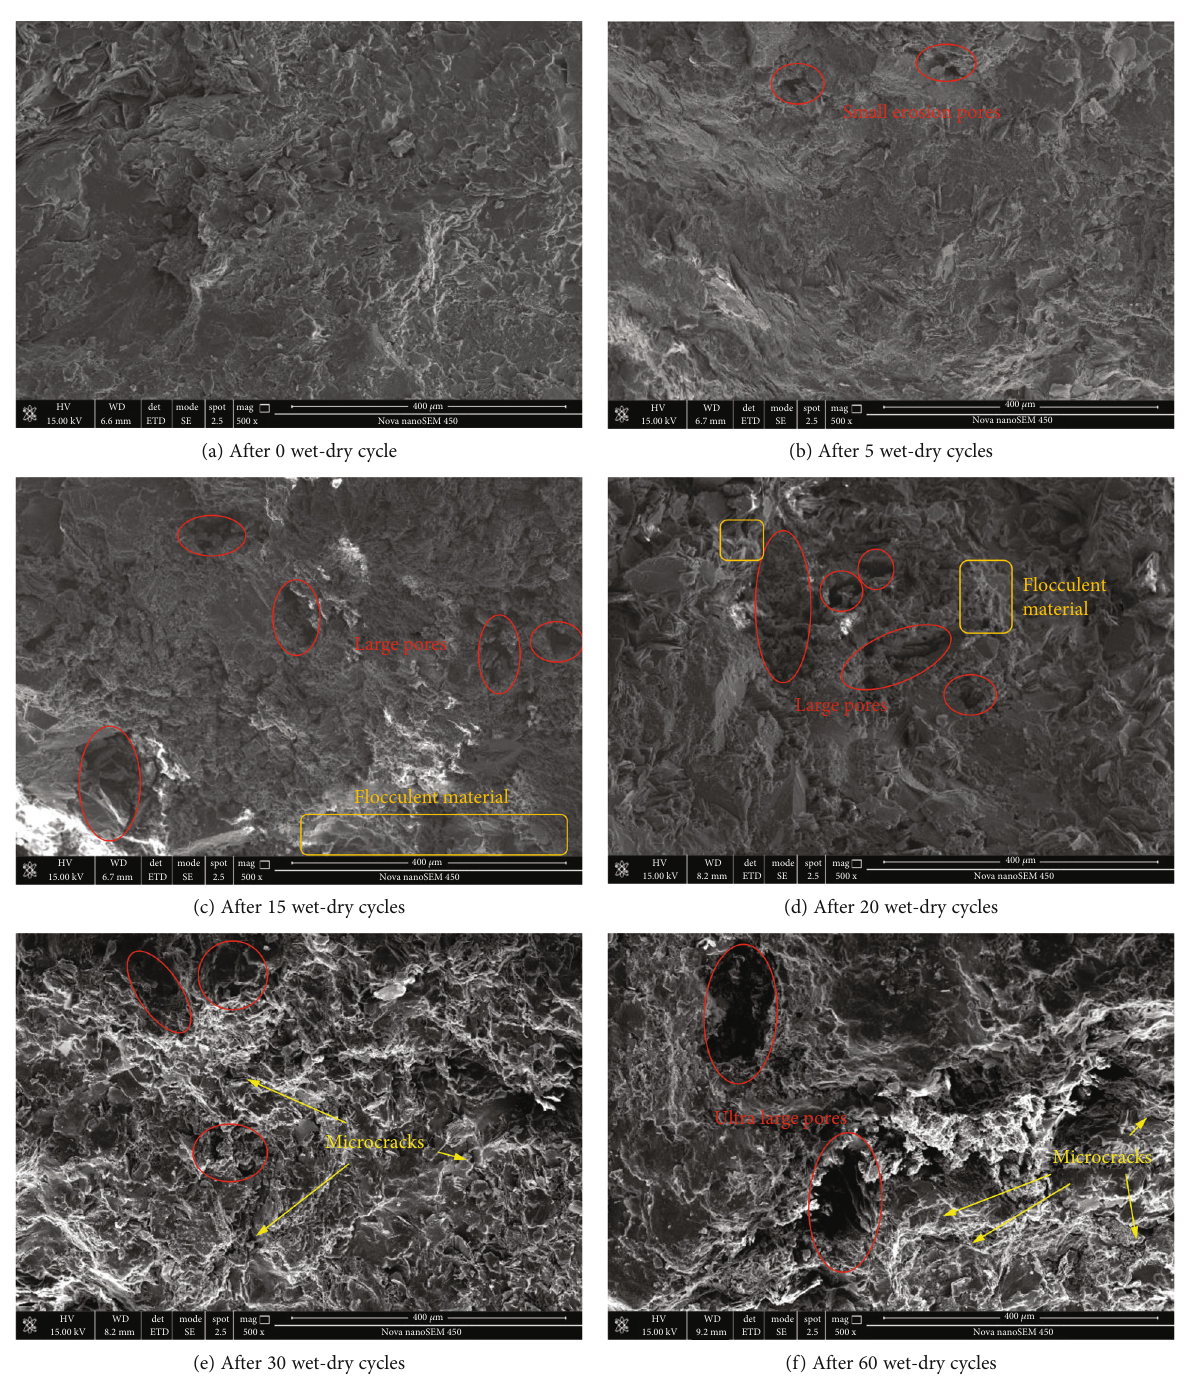
Figure 14: SEM images of rock surfaces after di ff erent wet-dry cycles (after